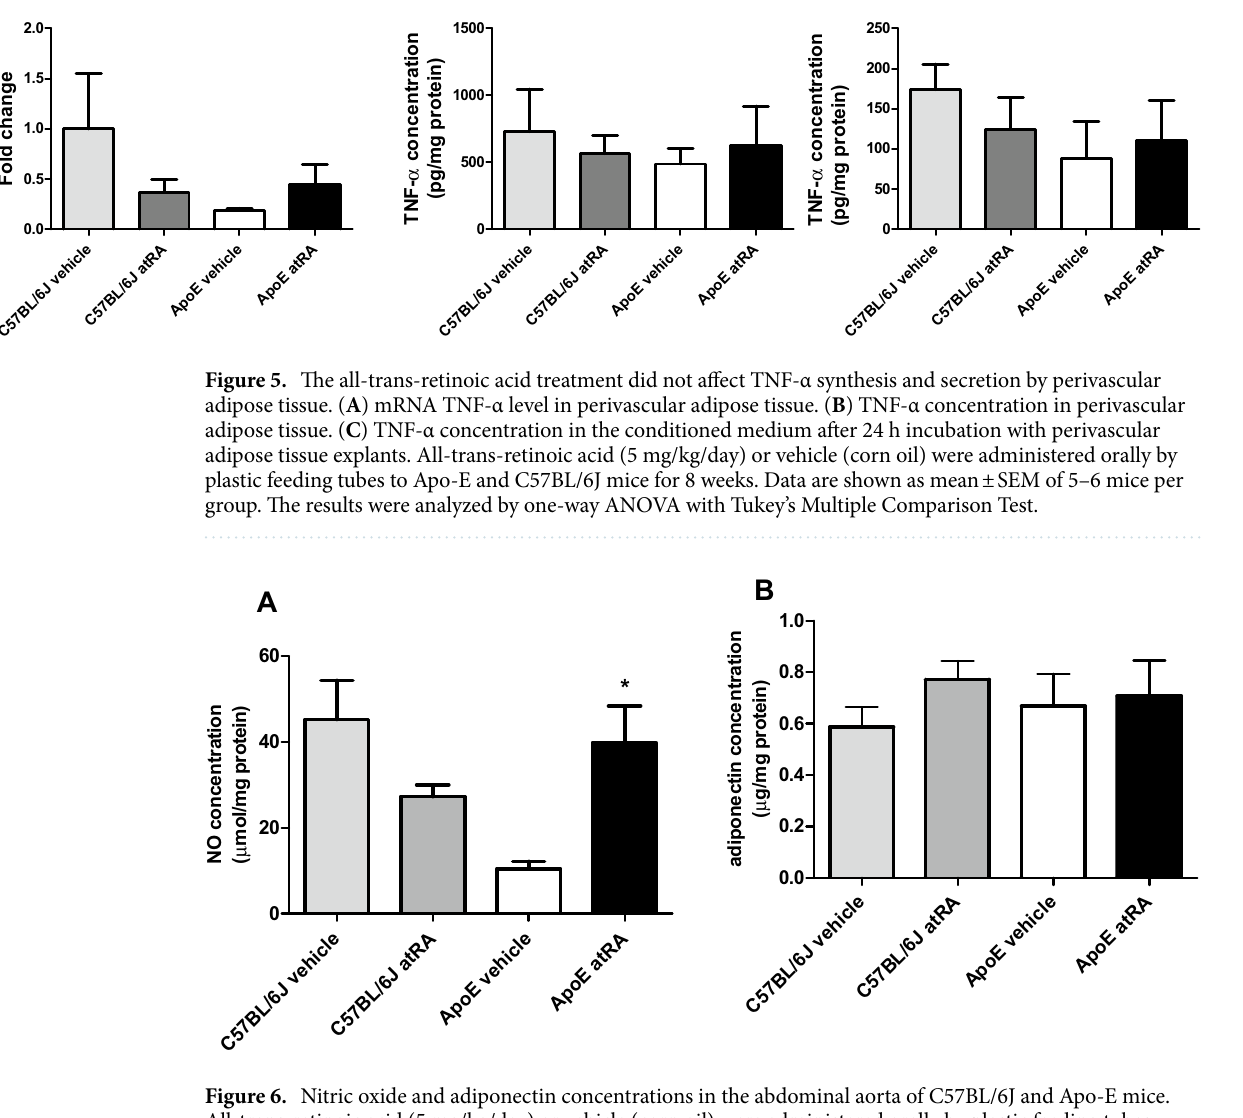
Figure 6. Nitric oxide and adiponectin concentrations in the abdominal aorta of C57BL/6J and Apo-E mice. All-trans-retinoic acid (5 mg/kg/day) or vehicle (corn oil) were administered orally by plastic feeding tubes to Apo-E and C57BL/6J mice for 8 weeks. ( A ) Nitric oxide level in the abdominal aorta. ( B ) Adiponectin concentration in the abdominal aorta. Data are shown as mean ± SEM of 5–6 mice per group. The results were analyzed by one ‐ way ANOVA with Tukey’s Multiple Comparison Test. *p < 0.05 ApoE atRA vs. ApoE